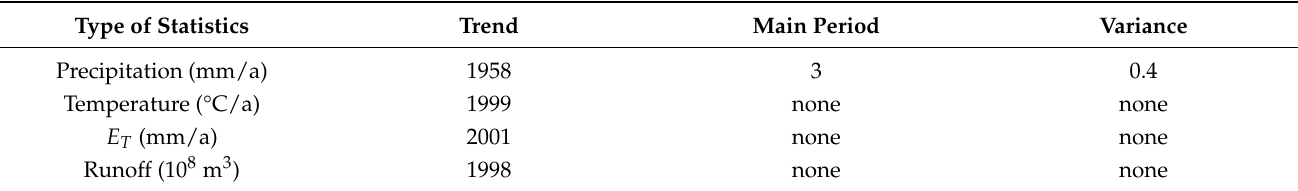
Figure 9. Wavelet variance of the Guanyintang station. ( a ) Precipitation; ( b ) temperature; ( c ) runoff; ( d ) evapotranspiration. Table 4. Results of the wavelet analysis in the Guanyintang